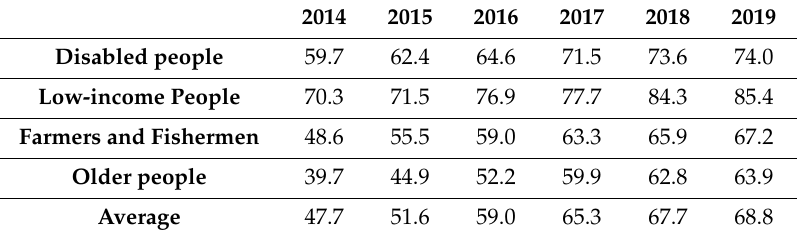
Table 8. Digital Utilization Level of four